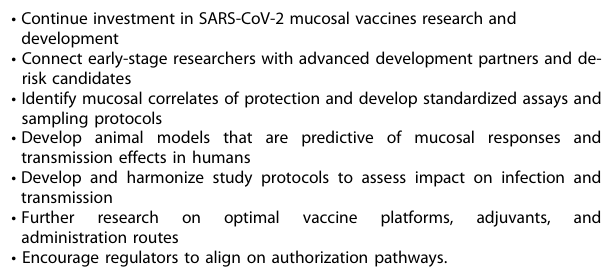
Box 1 Key recommendations for the development of mucosal vaccines for SARS-CoV-2 (cid:129) Continue investment in SARS-CoV-2 mucosal vaccines research and